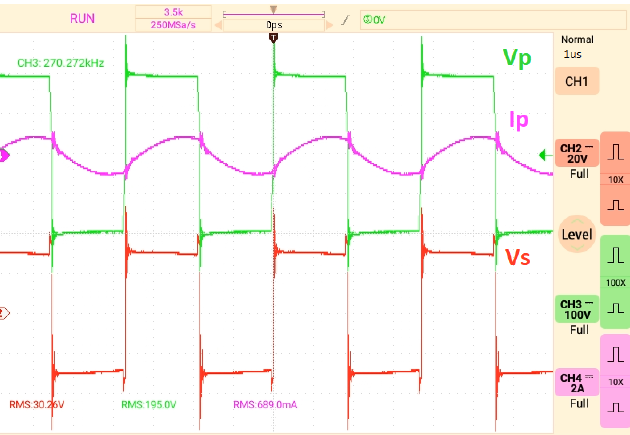
Figure 14. LLC resonant converter FM experimental results V o = 29.4 V, I o = 3 A, f sw = 270 kHz.